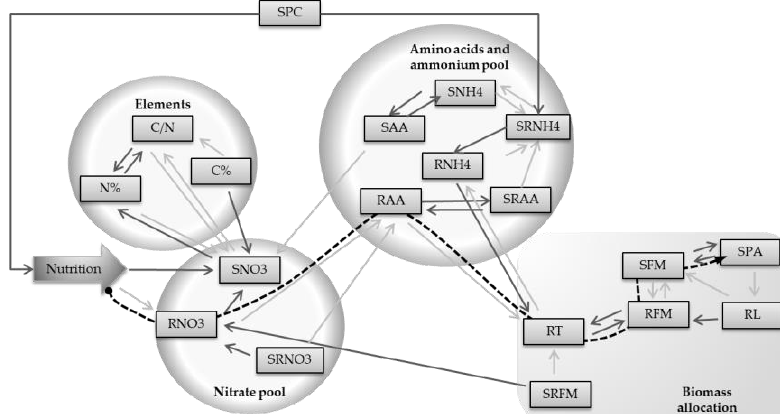
Figure 8 . Descriptive model of morphological and metabolic responses to N nutrition. Traits are linked to each other by strong correlative relationships. Dark and light grey arrows link traits with the first and second highest correlated traits, respectively, according to Pearson’s correlation matrix (Supplemental Table S5). The black dotted line indicates the pathway used in the model to estimate RFM, SFM and SPA from the nutrition regime. Four groups of correlated traits are classified as elements, nitrate pool, free amino acids-ammonium pool, and biomass allocation. Table 1. Formulas and parameters used by the model to estimate morphological traits according to N nutrition status. In the first three columns, the traits included in the descriptive model are listed, and the formulas and model parameters that fit with all the data. Model parameters refined for each genotype in the three experiments are listed in the Supplemental Table S6.